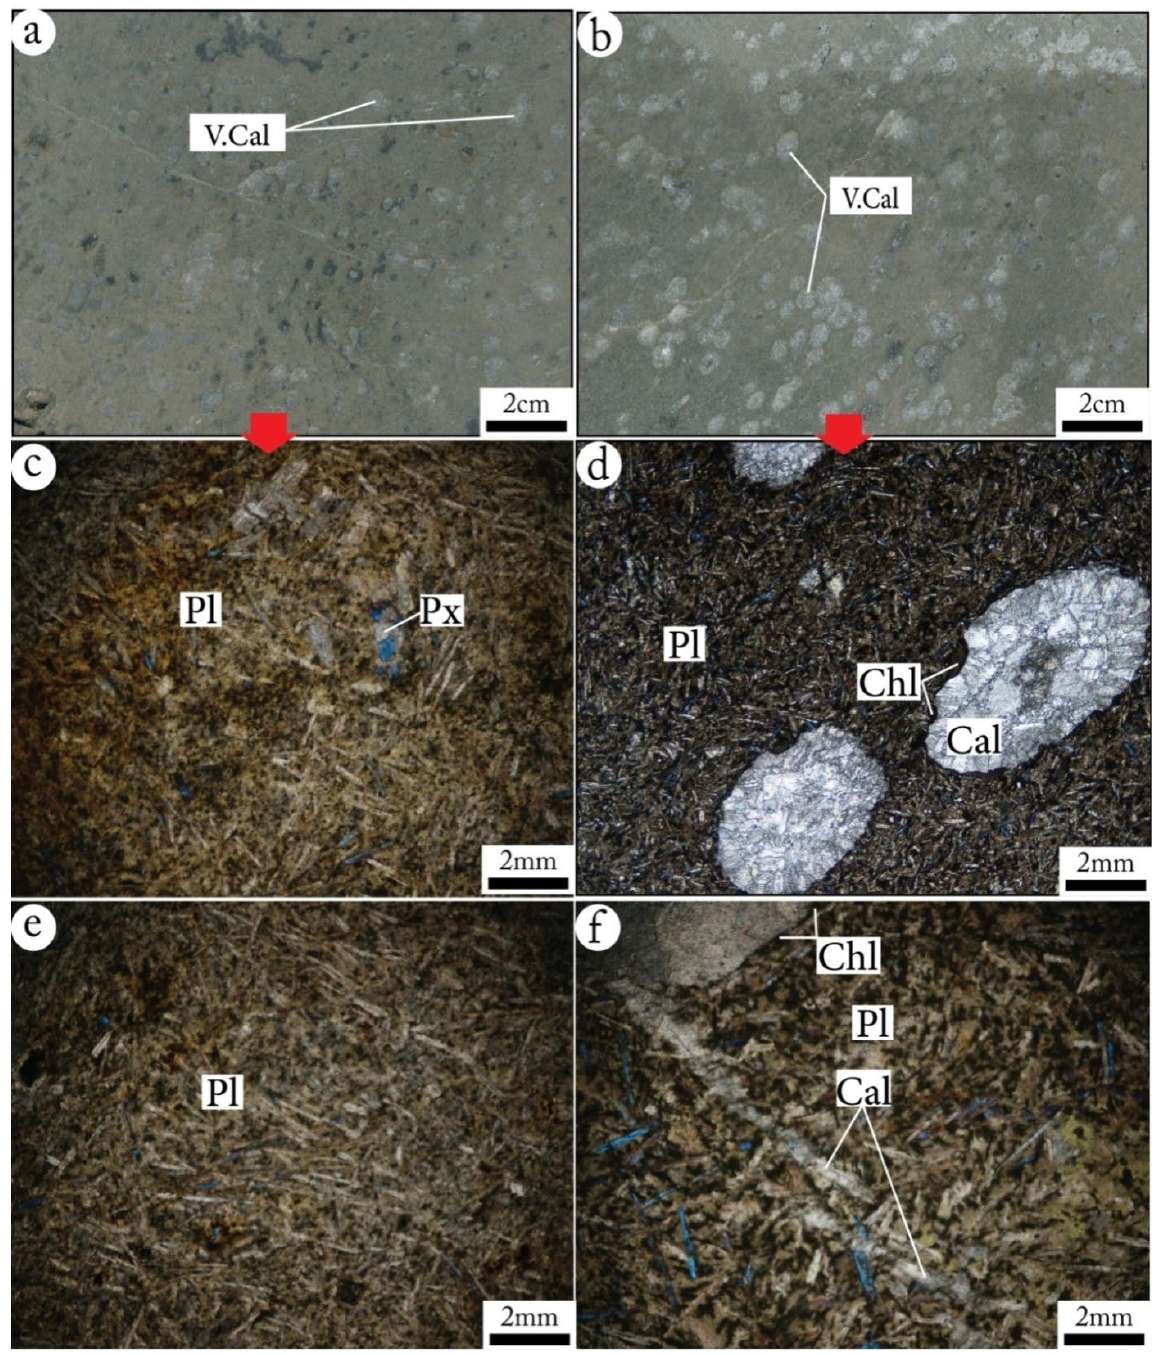
Figure 13. Macroscopic view ofpillow-lavas less ( a ) and rich ( b ) in calcitic vacuoles, and micropho- tographs of this facies in transmitted light with crossed nocols ( c – f ). V.Cal : vacuolar calcite, Pls: plagioclase, Cal: calcite, Chl: chloriteandPxs: